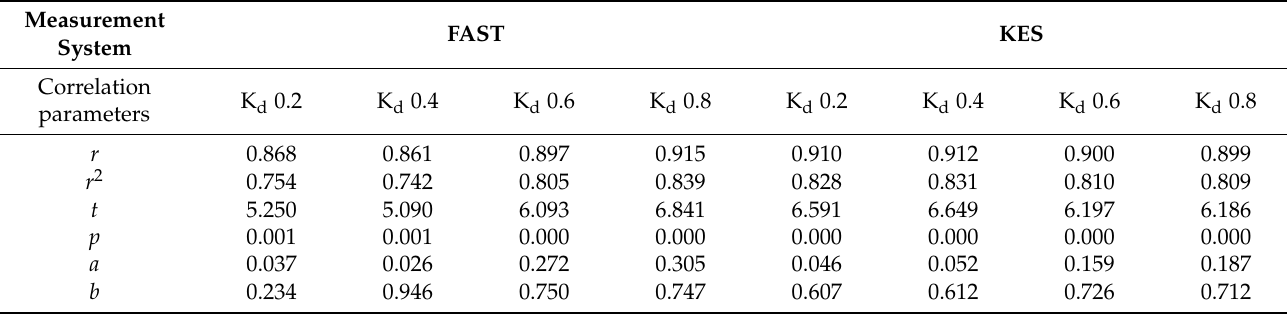
unit change in the independent variable).